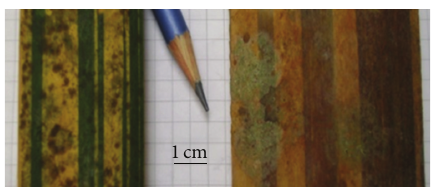
1 cm Figure 9: Color comparison of two samples: submerged in water (left) and exposed to air (right).